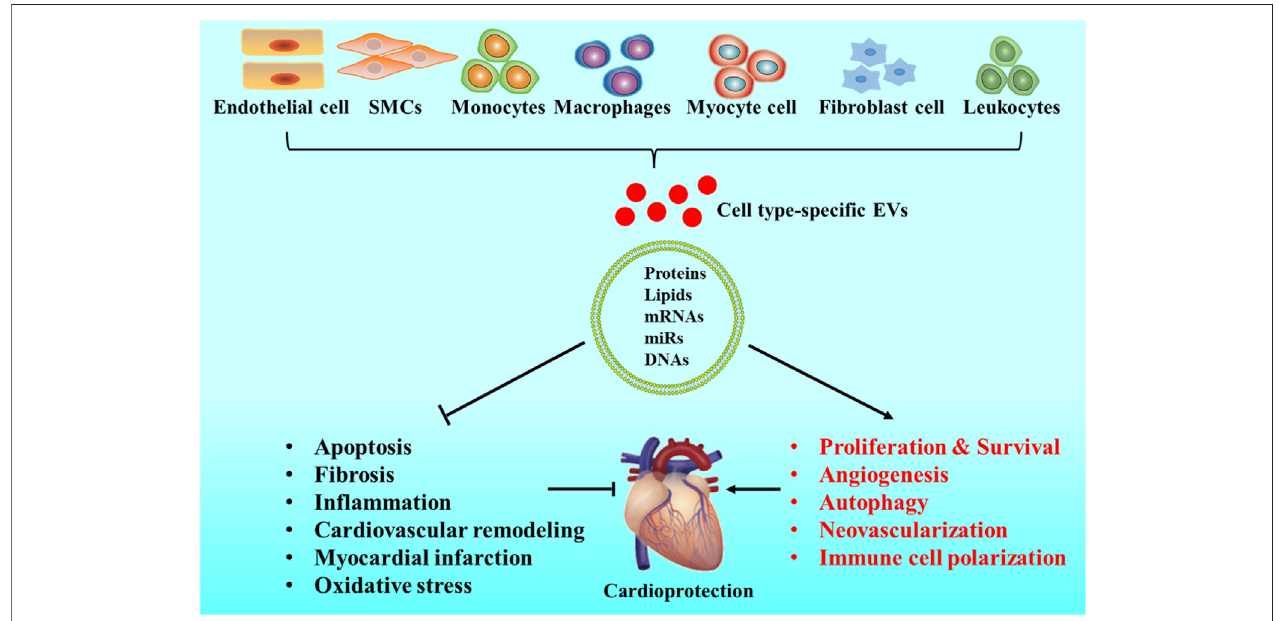
FIGURE 3 | Origins and roles of EVs in CVDs. EVs can be released by cardiovascular system-related cells, such as cardiomyocytes, endothelial cells (ECs), fi broblasts, smooth muscle cells (SMCs), leukocytes, monocytes, and macrophages. EVs mimic the cardioprotective properties by stimulating cell proliferation, improving cardiac survival, activating cell autophagy, promoting angiogenesis, enhancing neovascularization, decreasing cell apoptosis, reducing tissue fi brosis, preventingin fl ammation,inhibitingcardiovascularremodeling,treatingmyocardialinfarction,reducingoxidativestresslevels,andaffectingimmunecellpolarization.